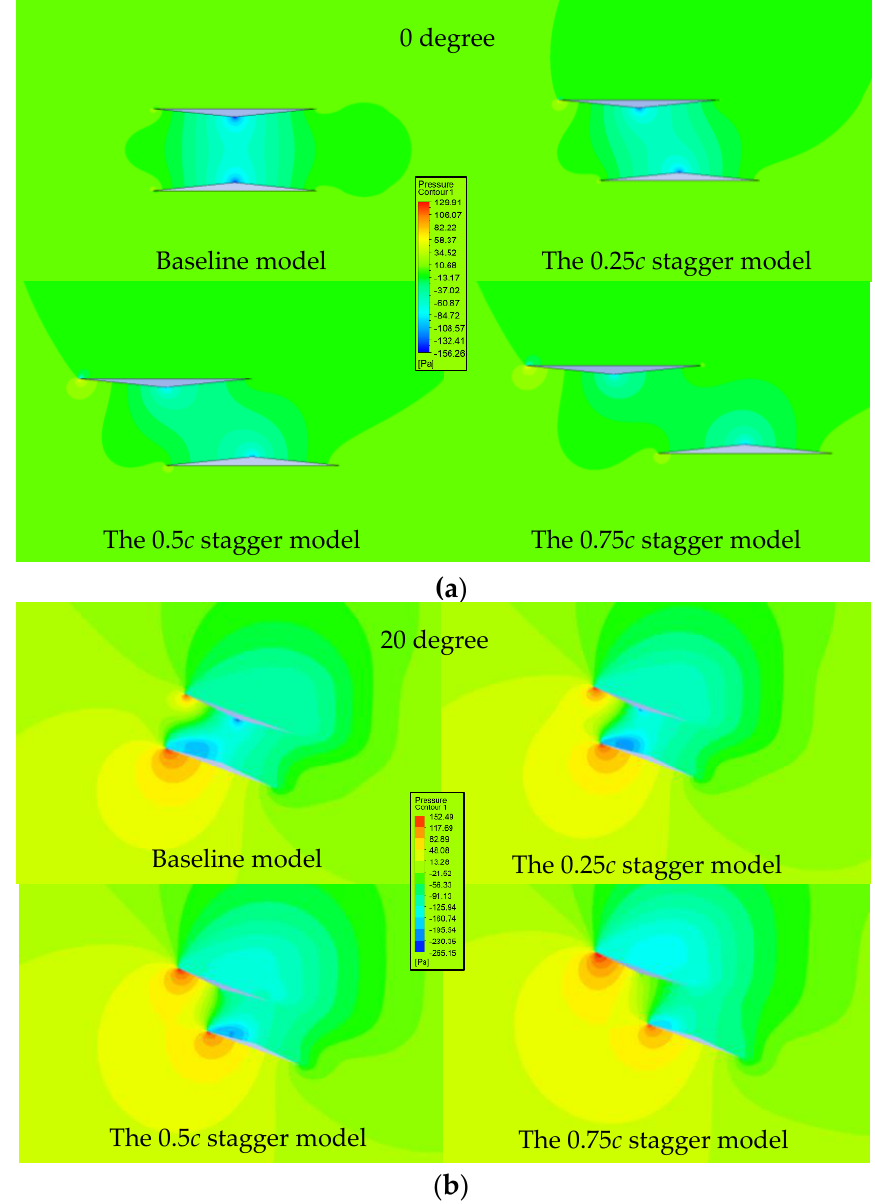
Figure 13. Pressure distributions around the staggered biplane configuration (CFD results): ( a ) 0 degrees; ( b ) 20 degrees.